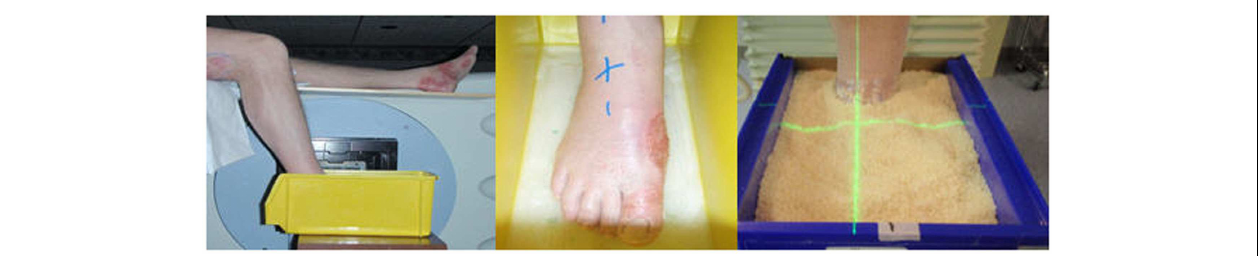
FIGURE 1 | Clinical setup for patientA .